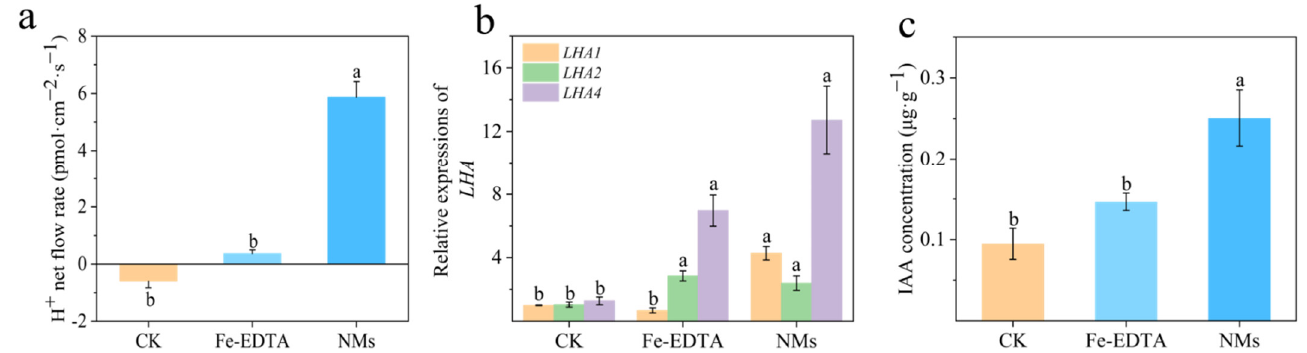
Figure 4. Fe 7 (PO 4 ) 6 NMs stimulated root PM H + ATPase and IAA accumulation. ( a ) H + net flow rate of tomato seedling root elongation zone. Negative value means H + influx and positive value means efflux. ( b ) relative expressions of LHA in tomato roots. ( c ) IAA concentration in tomato roots. Different letters in represent significance of p < 0.05.